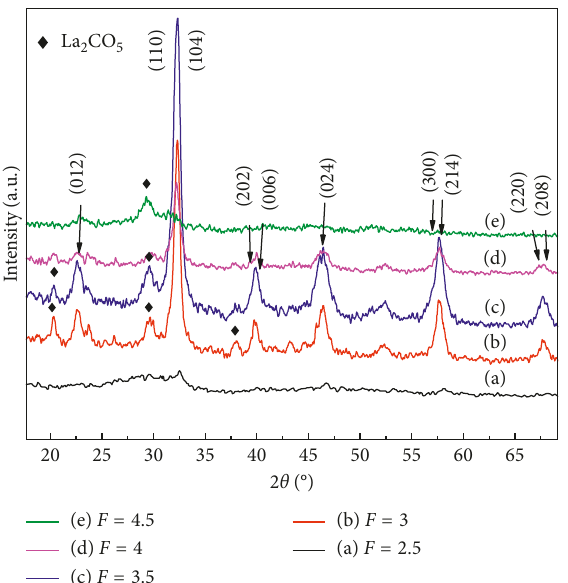
3 samples with F (cid:31) 3 and 3.5